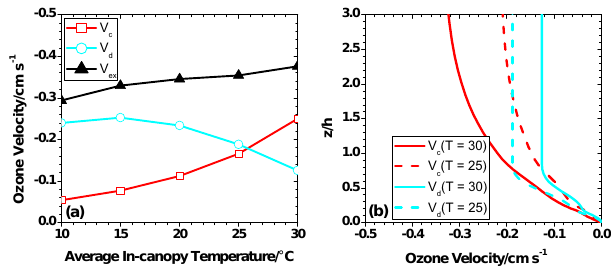
Fig. 4. (a) Influence of air temperature on modeled chemical ve- locity ( V c ) , stomatal deposition velocity ( V d ) and total exchange velocity ( V ex ) for ozone at z/h =1.25. (b) Vertical profiles of the ozone chemical and stomatal deposition velocity for average in- canopy temperatures of 30 ◦ C and 25 ◦ C.